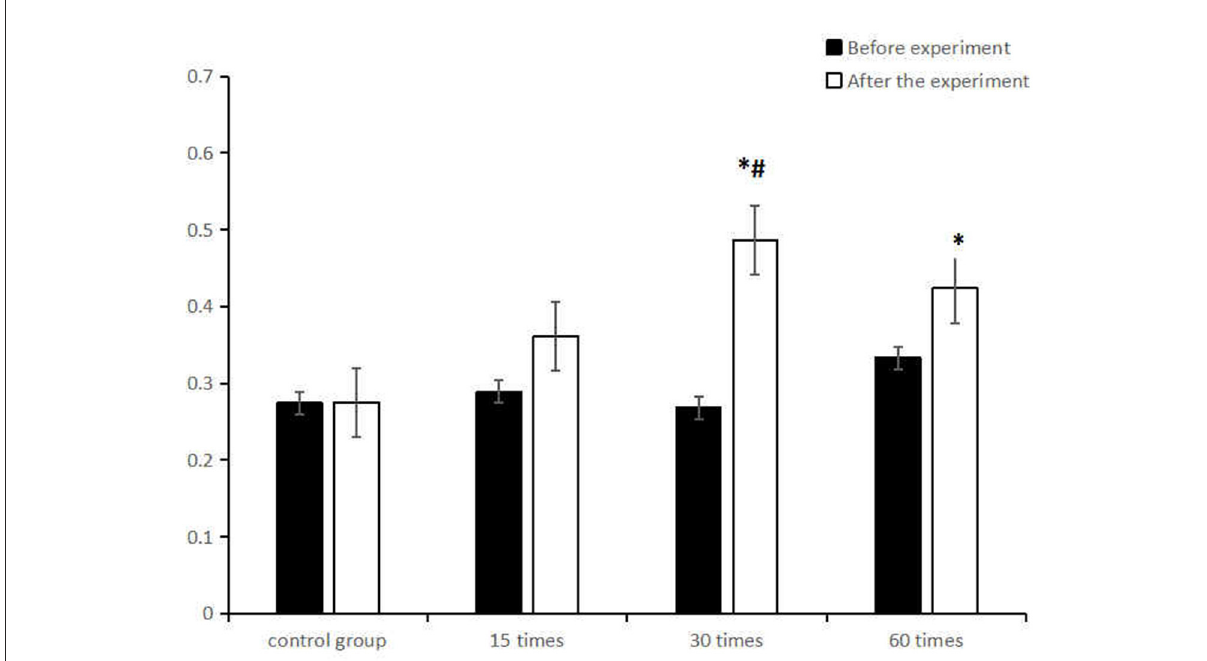
FIGURE1 Comparison of the mean (M ± SD)kinetic visual acuity between the control group and the ciliary muscle training group with different frequencies before and after the experiment. *represents significant difference in intra-group comparison ( p < 0.05), # represents significant difference in comparison with the control group after the experiment ( p < 0.05).